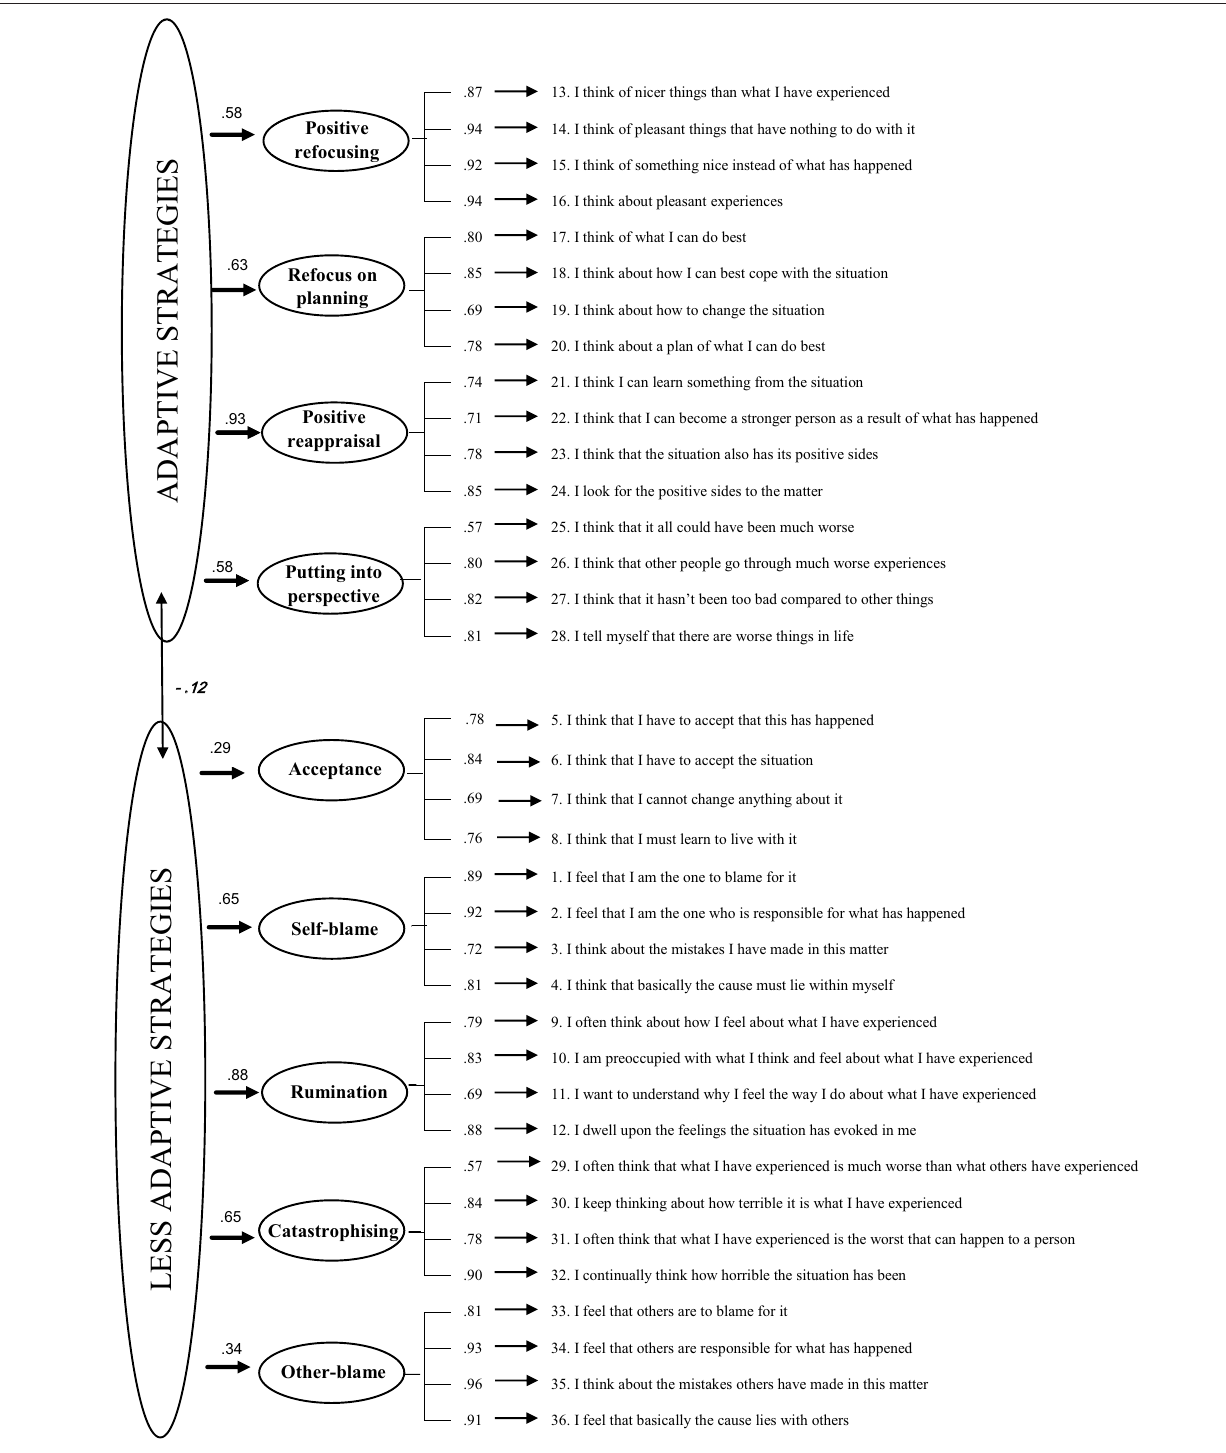
Frontiers in Psychology |